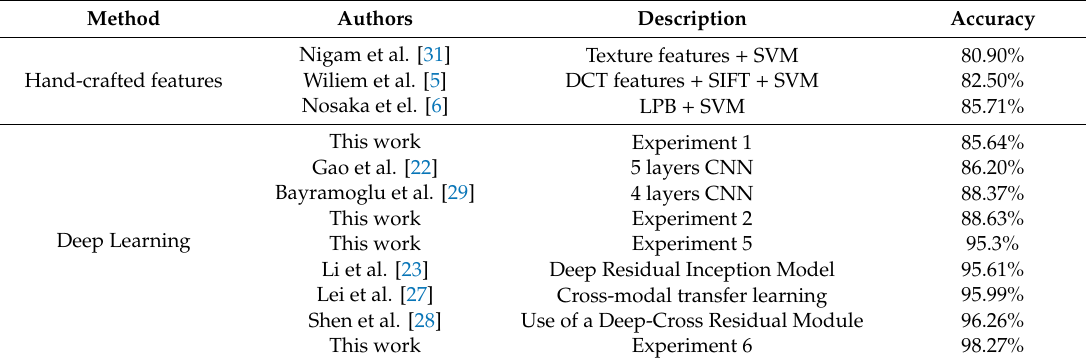
Table 1. Comparative study for the SNPHEp-2